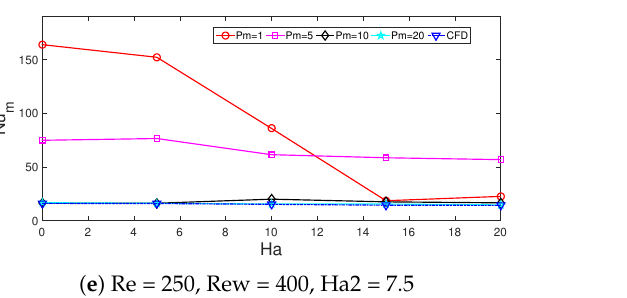
Figure 8. Modal coefficients’ variations with changes in Rew ( a ), Ha ( b ) and approximation of average Nu from the hot cylinder with different numbers of modes and variations with respect to changes in Re ( c ), Rew ( d ) and Ha ( e